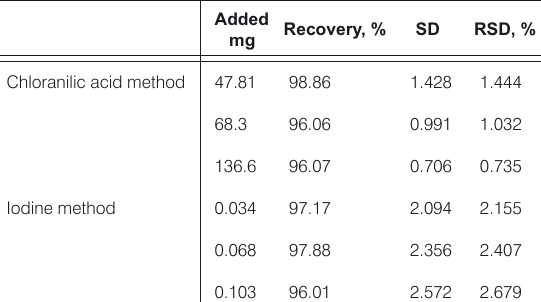
Table 4. Determination of SU in Dogmatil ® Fort tablets by the proposed methods.